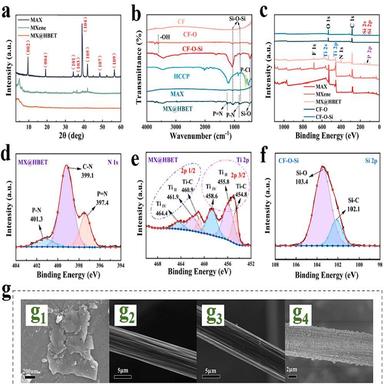
(a) XRD of MAX, MXene, and MX@HBET; (b) FTIR spectra; (c) XPS survey spectrum; High-resolution XPS spectrum (d) N 1 s of MX@HBET, (e) Ti 2p of MX@HBET and (f) Si 2p of CF-O-Si; The SEM images (g) of (g1) CF, (g2) CF-O, (g3) CF-O-Si and (g4) MX@HBET.